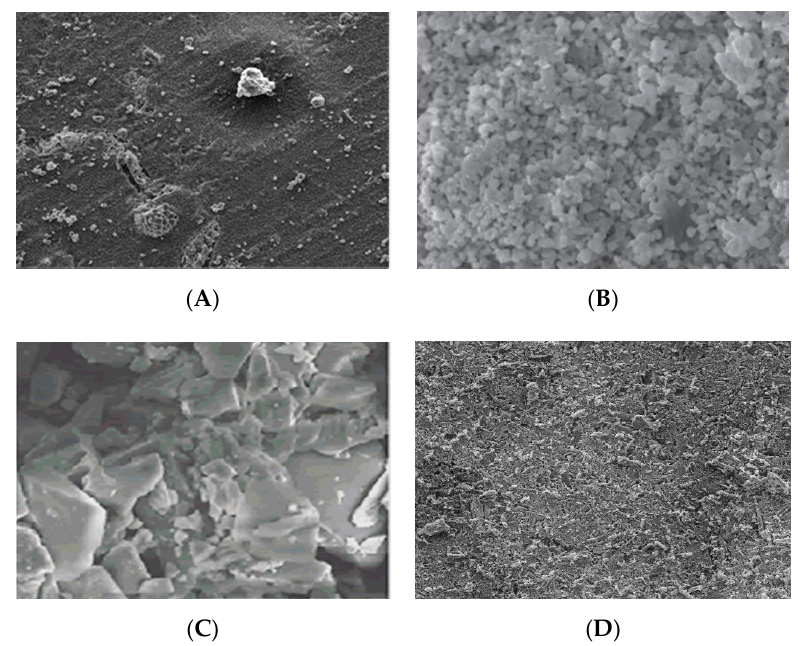
Figure 2. SEM images of bioceramics currently used for bone implants vs wollastonite ( A ) Hydrox-